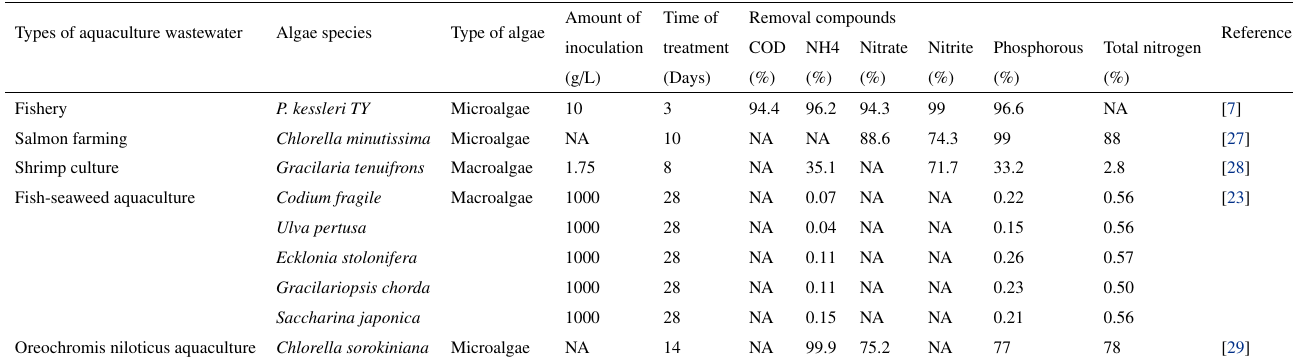
Table 2. Nutrient removal in aquaculture wastewater with di ff erent algal species